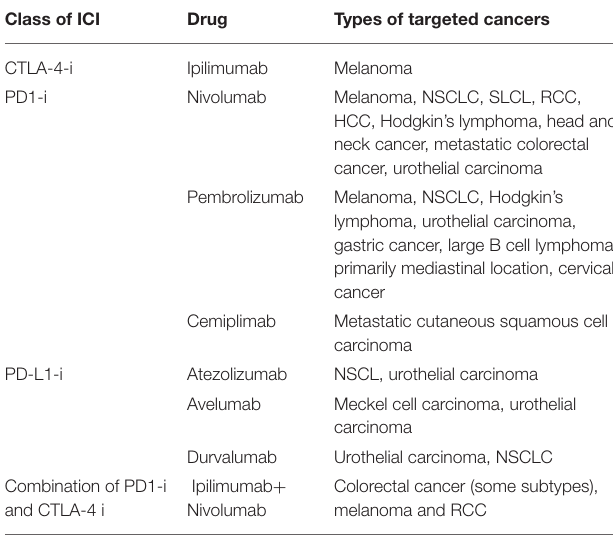
TABLE 1 | Types of checkpoint inhibitors and targeted